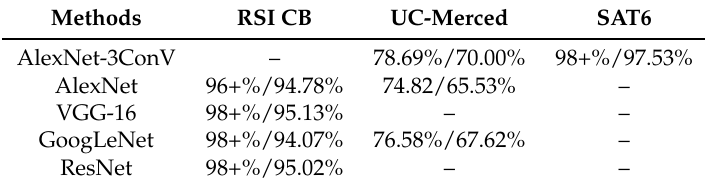
Table 7. OA of training and test data sets using deep convolutional neural network (DCNN).